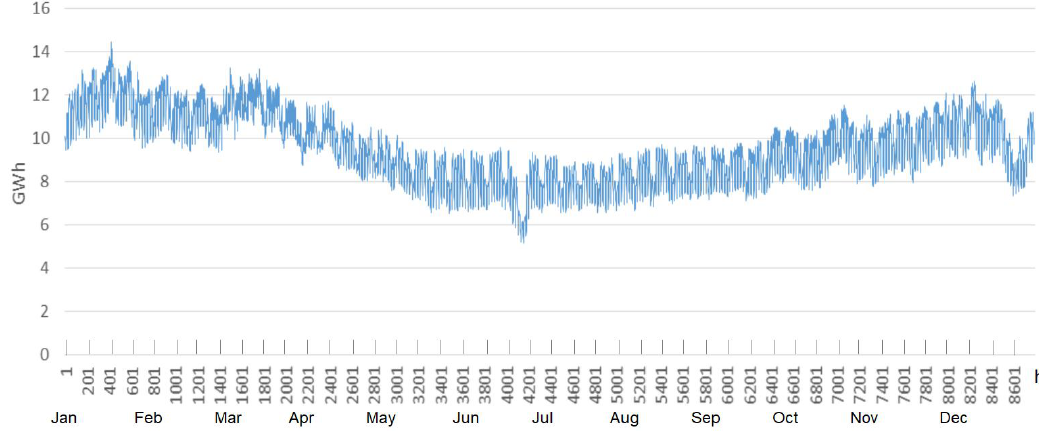
Figure 12. Hourly electricity demand for Finland in 2013.